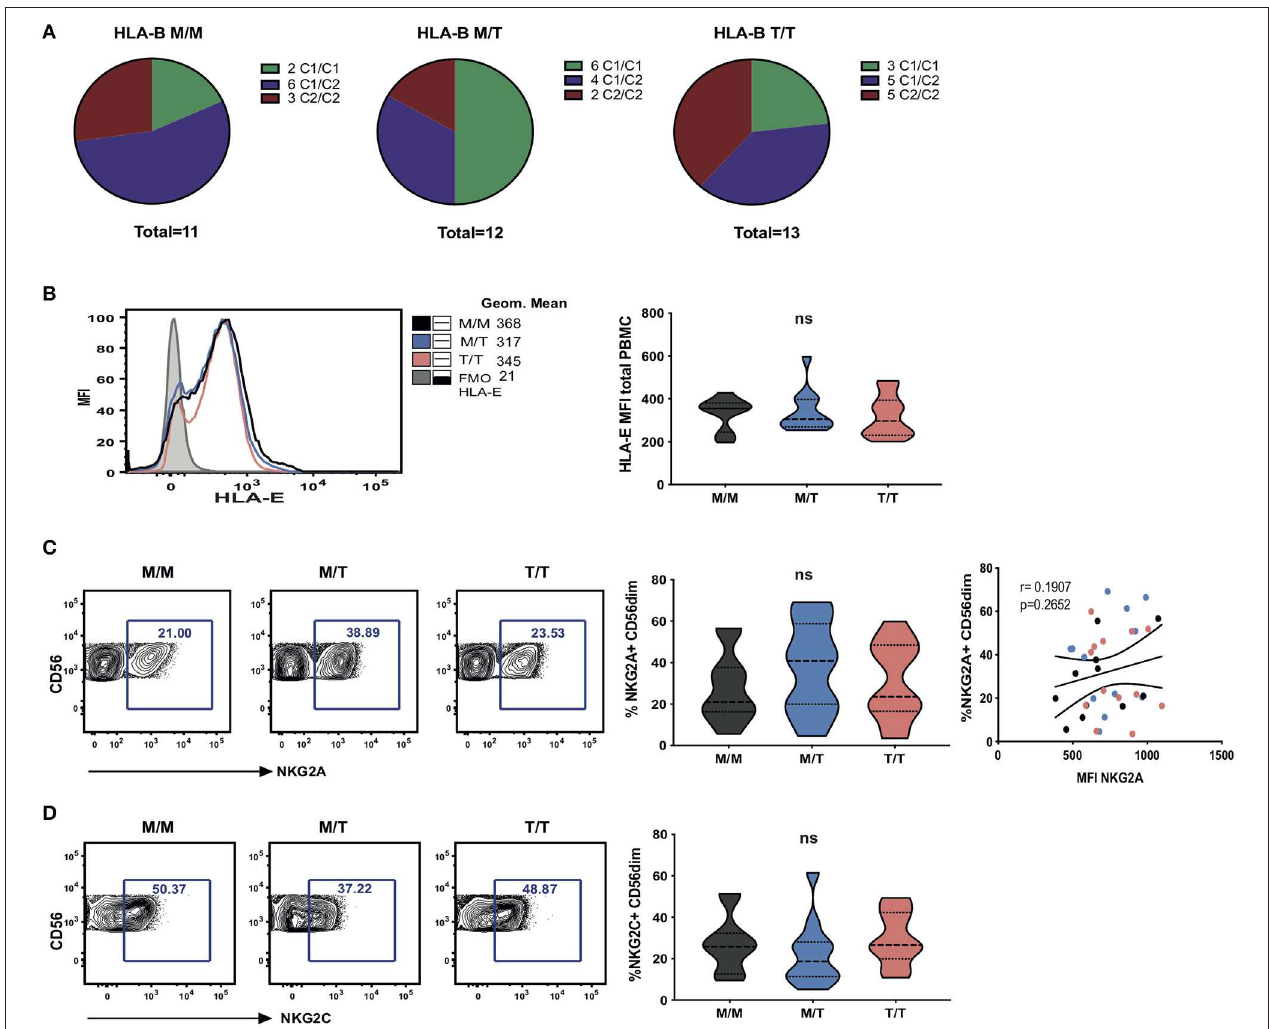
FIGURE 1 | Dimorphism at position -21 HLA-B does not significantly modulate HLA-E and NKG2A expression. (A) HLA haplotypes encoding HLA-C1 and C2 within groups of -21 HLA-B genotype M/M homozygous, -21M/T heterozygous and -21 T/T homozygous subjects from the study cohort. (B) Representative histograms showing HLA-E expression on total PBMC between groups as well as fluorescence minus one (FMO) control staining (left); and comparison of cell-surface HLA-E expression (geometric mean fluorescence intensity (MFI) of staining with HLA-E-specific antibody 3D12) on total PBMC between groups (right). Data are displayed as violin plots; the group median and interquartile range are indicated. (C) Proportion of CD56 dim NK cells (i.e within live CD56 + CD3-CD19-CD14-CD4- PBMC) expressing NKG2A between groups and comparison of the percentage of NKG2A + CD56 dim with their level of surface expression (MFI) in M/M (black dots), M/T (blue dots) and T/T (pink dots) subjects. (D) Violin plots of the frequency of NKG2C expressing CD56 dim NK cells in the donor groups. Group median and interquartile range are indicated. All donors were HCMV positive. ns: